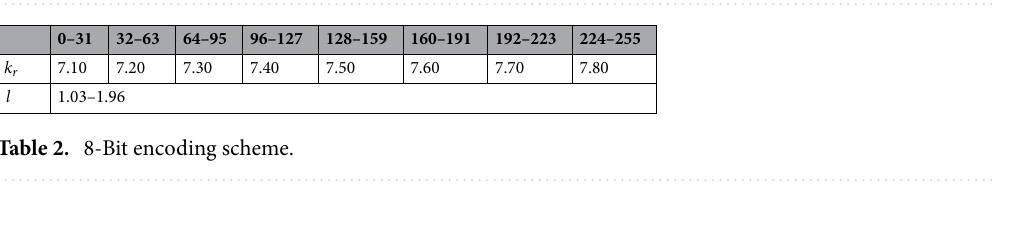
Figure 7. ( a ) A part of the confusion matrix obtained with a test set and ( b ) a graph of test accuracy versus the applied phase shift. Displayed numbers from 64 to 95 correspond to spatial modes given by combination of a radial wavenumber 7.30 and OAM modes from 1.03 to 1.96. The values inside the matrix represent the number of recognized spatial mode. The diagonal elements of the matrix indicate that the transmitted mode is correctly recognized. A unit of the phase shift here is rad/π.